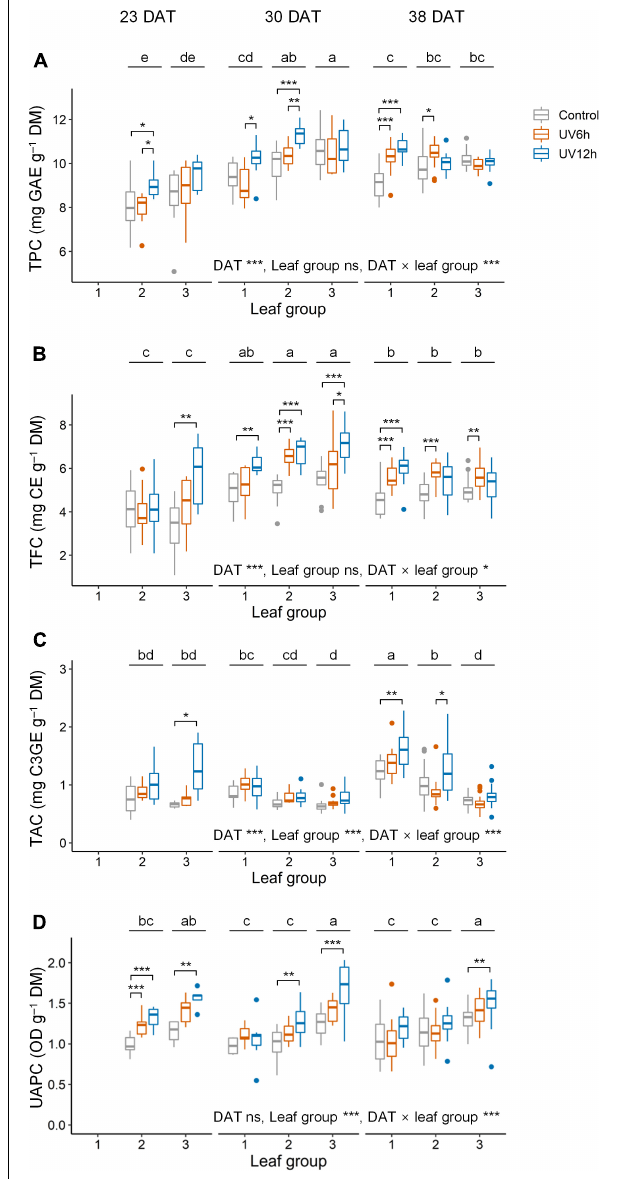
FIGURE 4 | Total phenolic content (TPC, A) , total flavonoid content (TFC, B) , total anthocyanin content (TAC, C) , and UV-absorbing pigment content (UAPC, D) in individual leaves of kale plants according to UV-B radiation and leaf group at 23, 30, and 38 days after transplanting (DAT). Leaf groups were determined according to the order of leaf emergence and their relative growth state ( Supplementary Figure 3 and Supplementary Table 1 ). Asterisks indicate significant differences between UV-B treatments at each growth stage and leaf group by one-way ANOVA and post-hoc test, * P < 0.05; ** P < 0.01; *** P < 0.001; n = 7–22. Different letters indicate significant differences among growth stage and leaf group at P < 0.05 by two-way ANOVA and post-hoc test ( n = 22–59) referring to the “Materials and Methods”